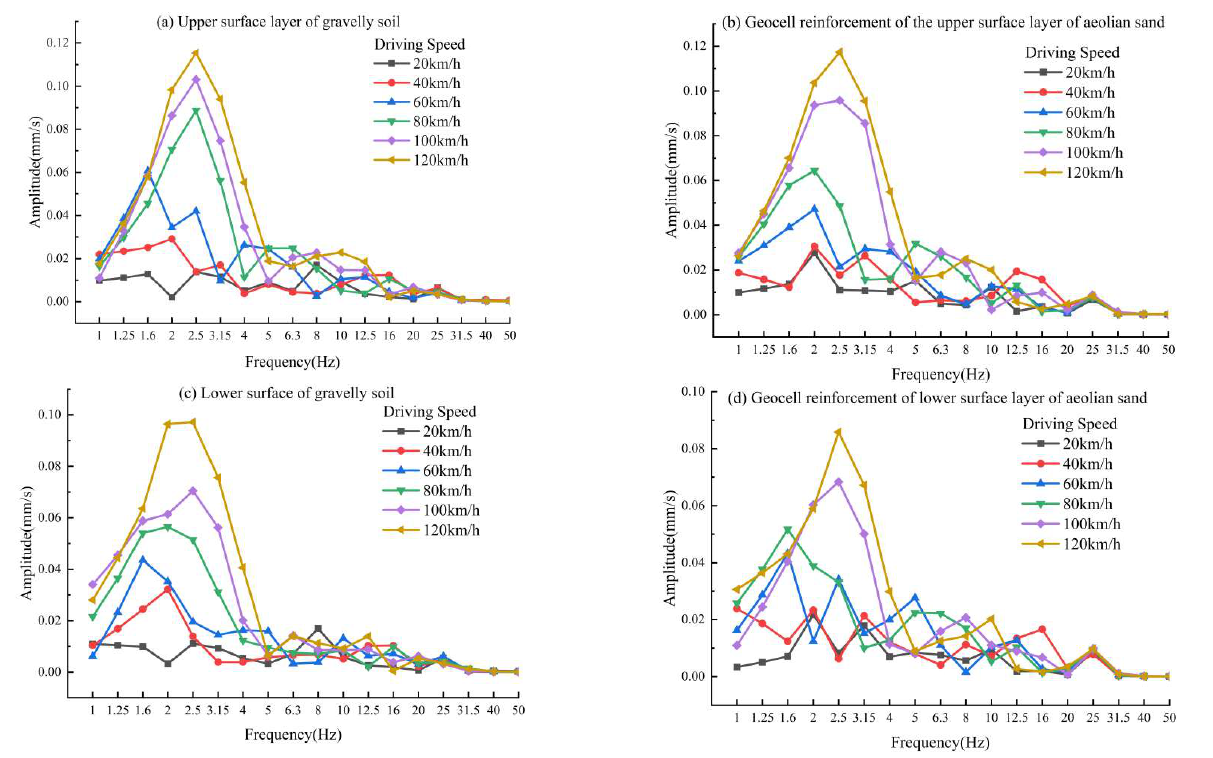
Figure 13. One-third frequency range analysis curve.